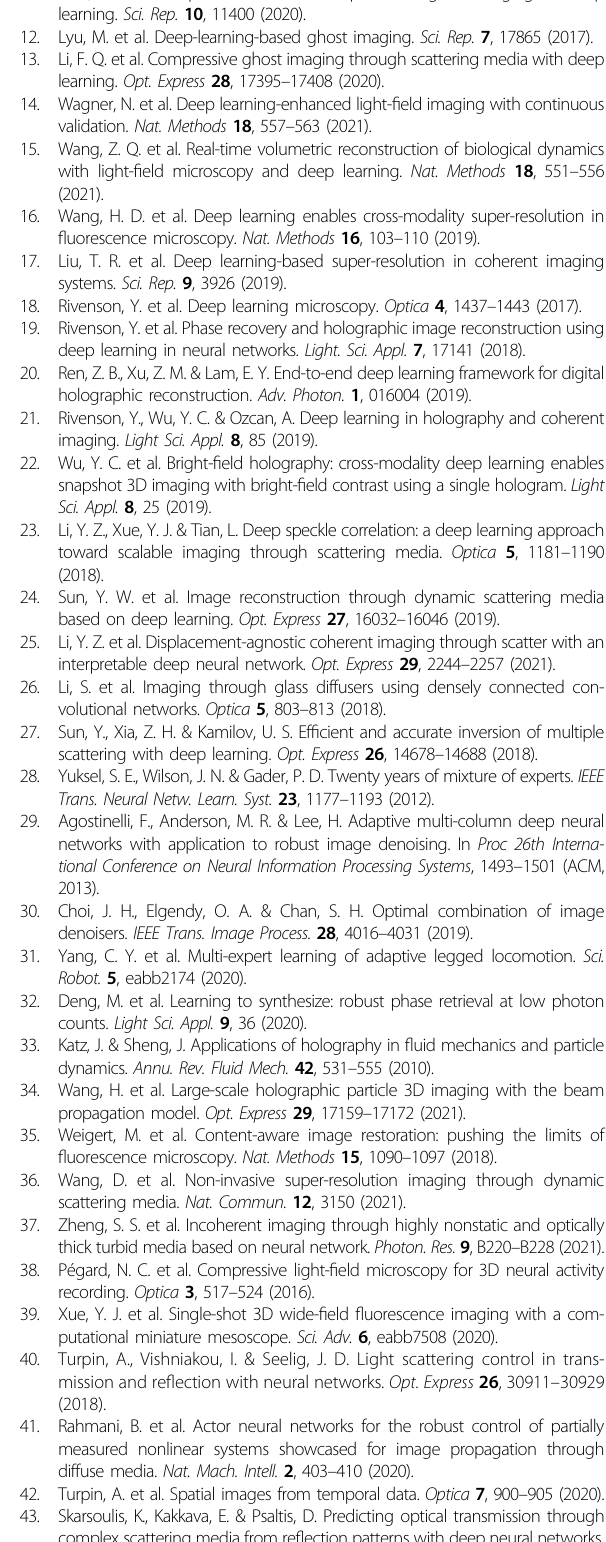
used Δ n = 0.01, 0.05, 0.10, 0.20, 0.26, 0.30, 0.40, 0.50. In Fig. 6d, for particles with density ρ = 6.41 × 10 4 particles μ L − 1 and refractive index contrast 0.26, we used in-total 960 non-overlapping hologram patches (128 × 128 pixels) cropped from 15 preprocessed holograms. For each par- ticle size, three preprocessed holograms are used. The following particle sizes are used Δ D = 0.30, 0.60, 1.00, 1.30, 1.50. In Fig. 6e, for particles with refractive index contrast 0.20 and particle diameter 0.6 µm, we use in-total 1728 non-overlapping hologram patches (128 × 128 pix- els) cropped from 27 preprocessed holograms. For each density, three preprocessed holograms (corresponding to 192 patches) are used. The following densities are used from ρ = {1.6, 3.34, 3.2, 4.81, 6.41, 9.61, 12.82, 19.23, 25.64} × 10 4 particles μ L − 1